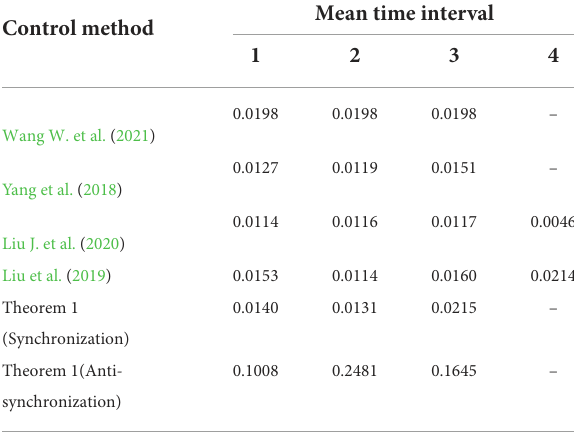
y ( t ) x ( t ). (B) Instants for anti-synchronization ε ( t ) = −